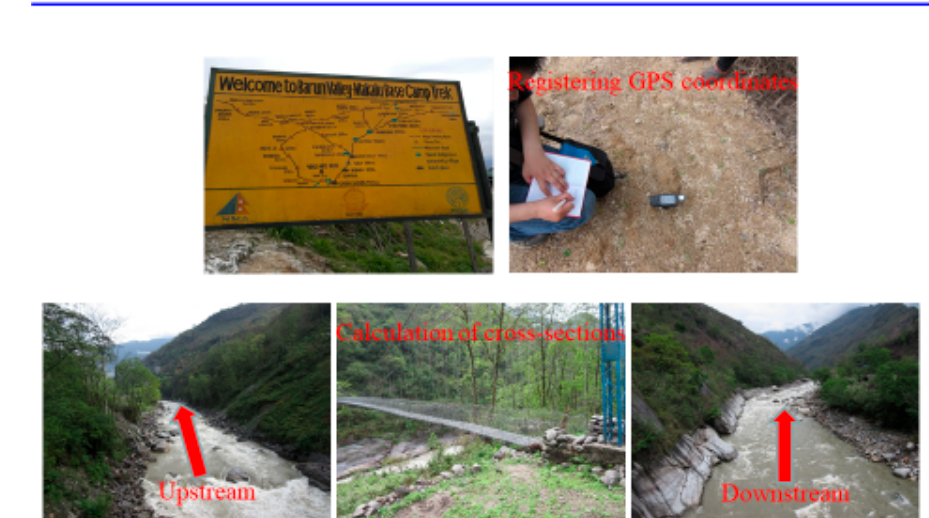
Figure A7. Interview with the locals. Water 2019 , 11 , x FOR PEER REVIEW